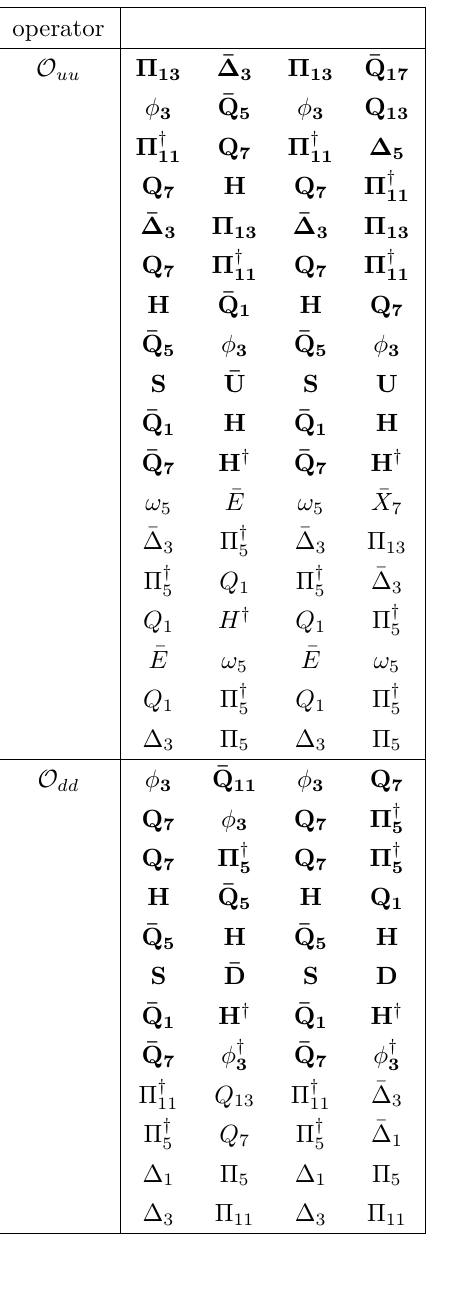
Table 15. Quark specific models, part 2. Boldface models are